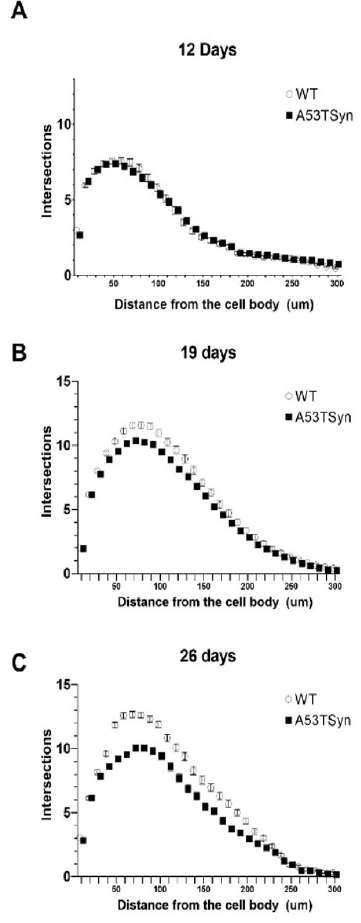
Figure 4. DMF attenuates elevated intracellular ROS in A53TSyn neurons. Levels of intracellular ROS were elevated in A53TSyn neurons relative to WT, and this increase was attenuated by treatment with DMF (20 µ M). ML385 (1 µ M) exacerbated the increased ROS in A53TSyn neurons. Significance is relative to control unless otherwise indicated ( * p < 0.05).